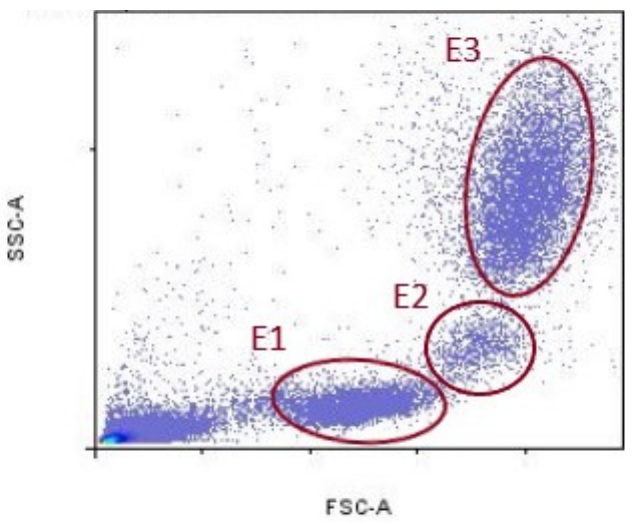
Figure 1. Representative gates for lymphocytes (E1), monocytes (E2), and granulocytes (E3).